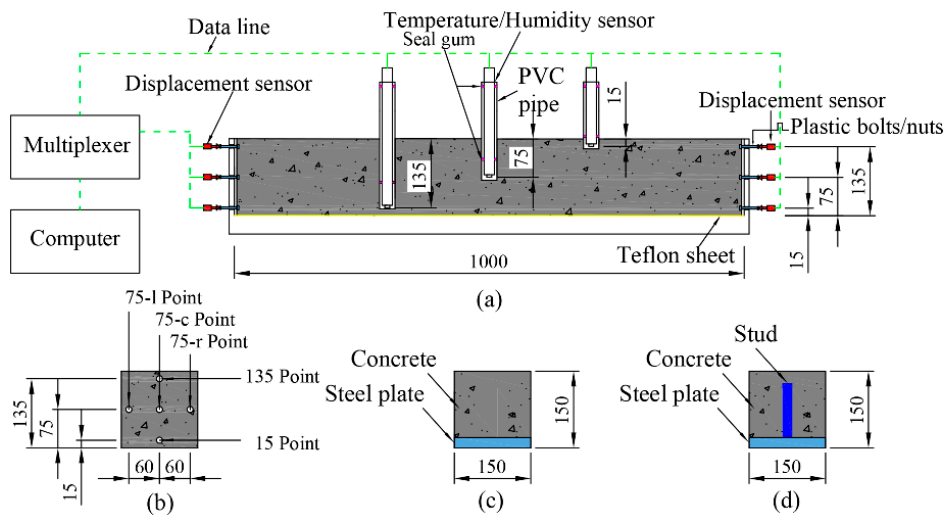
Figure 3. Shrinkage, temperature, and RH test setup for the HPC (mm): ( a ) schematic of the Plexiglas model, ( b ) distribution of the measurement position, ( c ) specimens with steel plate only, and ( d ) specimens with steel plate and stud. Table 3. List of experiments.